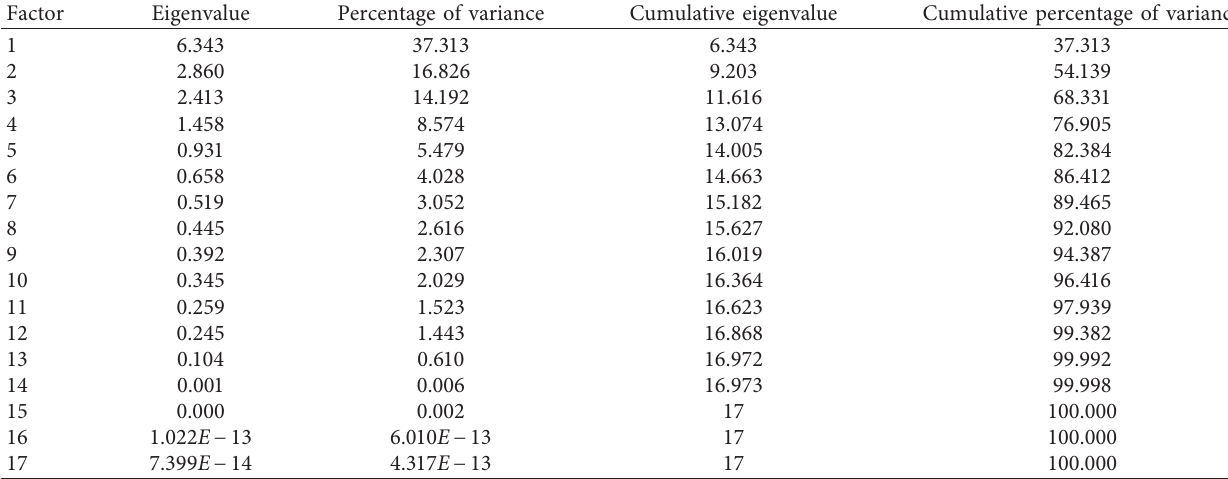
Table 3: Eigenvalues, percent of variance, cumulative eigenvalue, and cumulative percent of variance for factor analysis. Factor Eigenvalue Percentage of variance Cumulative